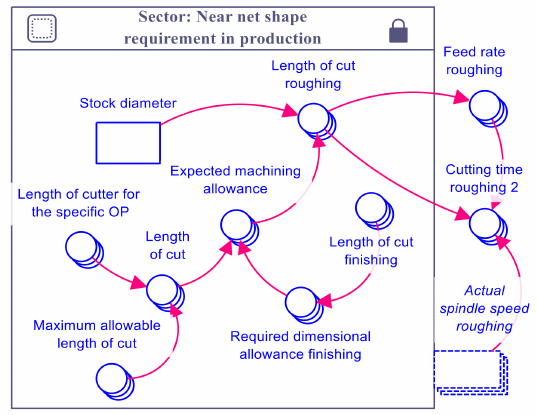
Figure 10. Structure of ‘near-net shape’ production